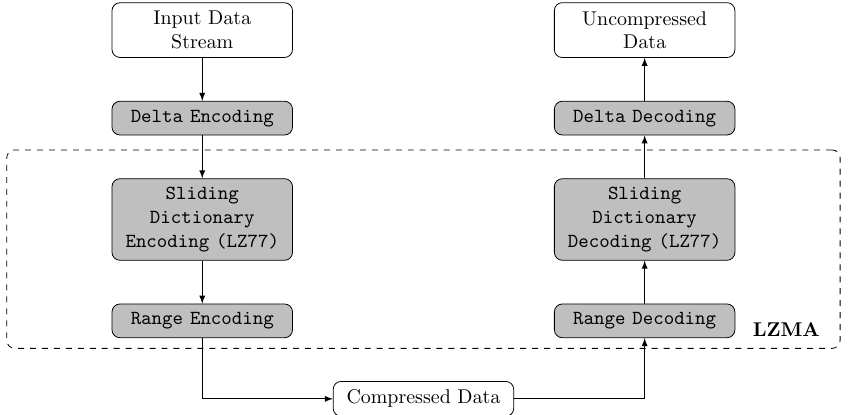
Figure 3. Lempel-Ziv Markov Chain Algorithm (LZMA) compression and decompression schemes, based on Reference